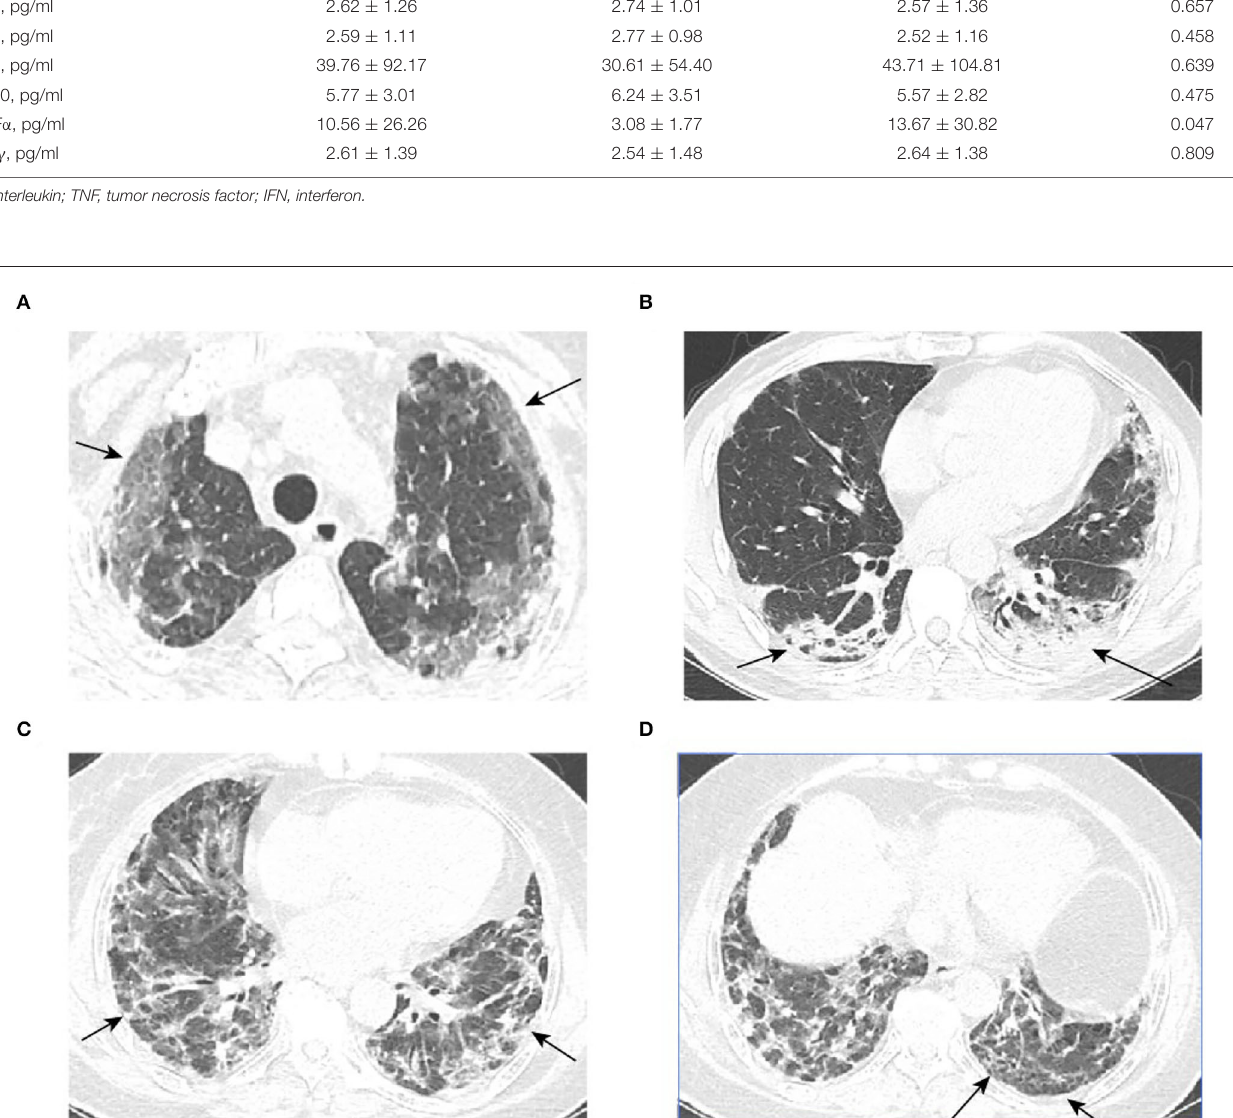
Frontiers in Medicine |